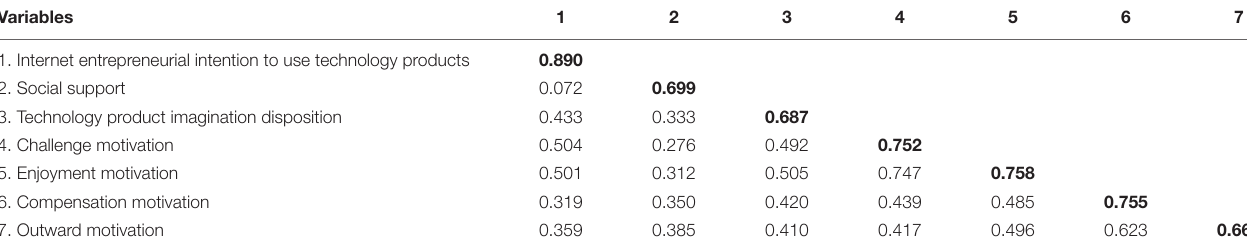
TABLE 5 | Discriminant